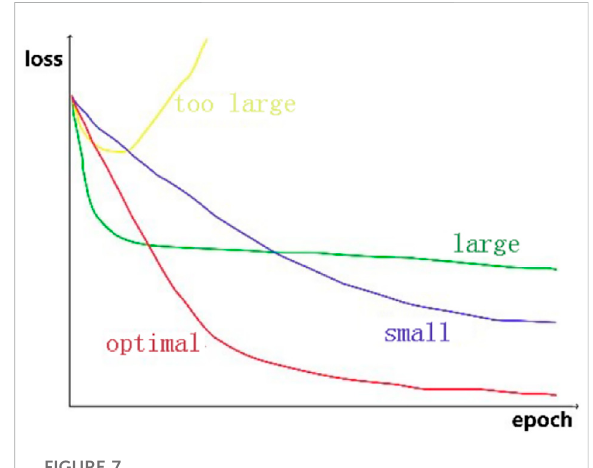
FIGURE 7 The in fl uence of learning rate decay type on loss